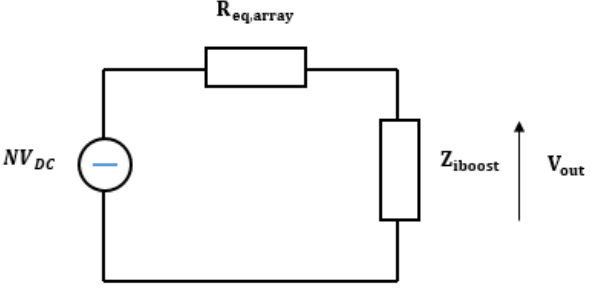
Figure 16. Circuit for the calculation of a rectenna array power.